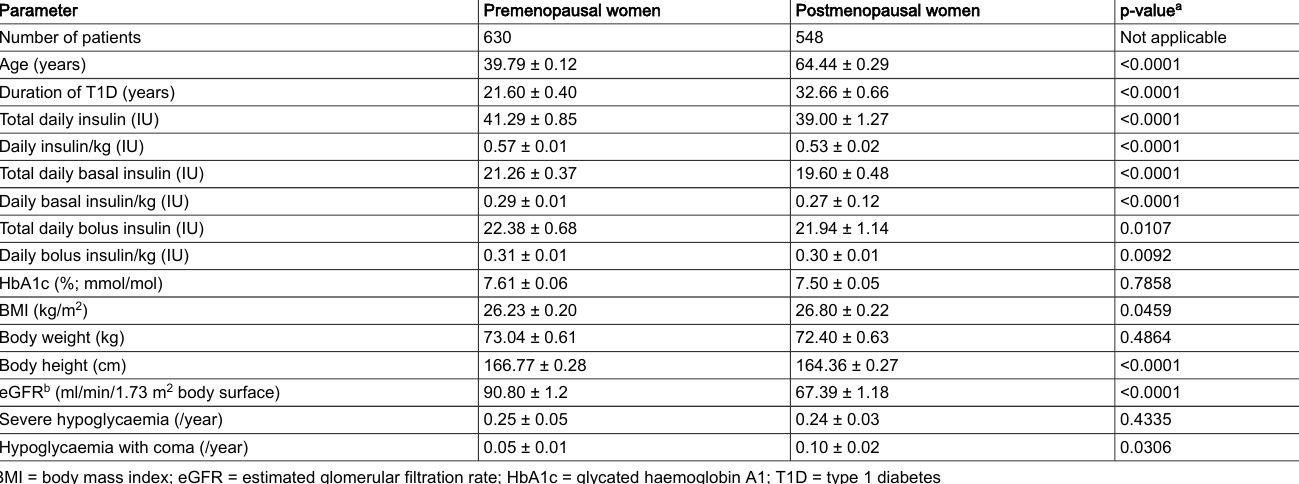
Table 1: Differences in demographic, clinical and anthropometric parameters between premenopausal women (age ≥35 to <45 years) and postmenopausal women (age ≥55 years).